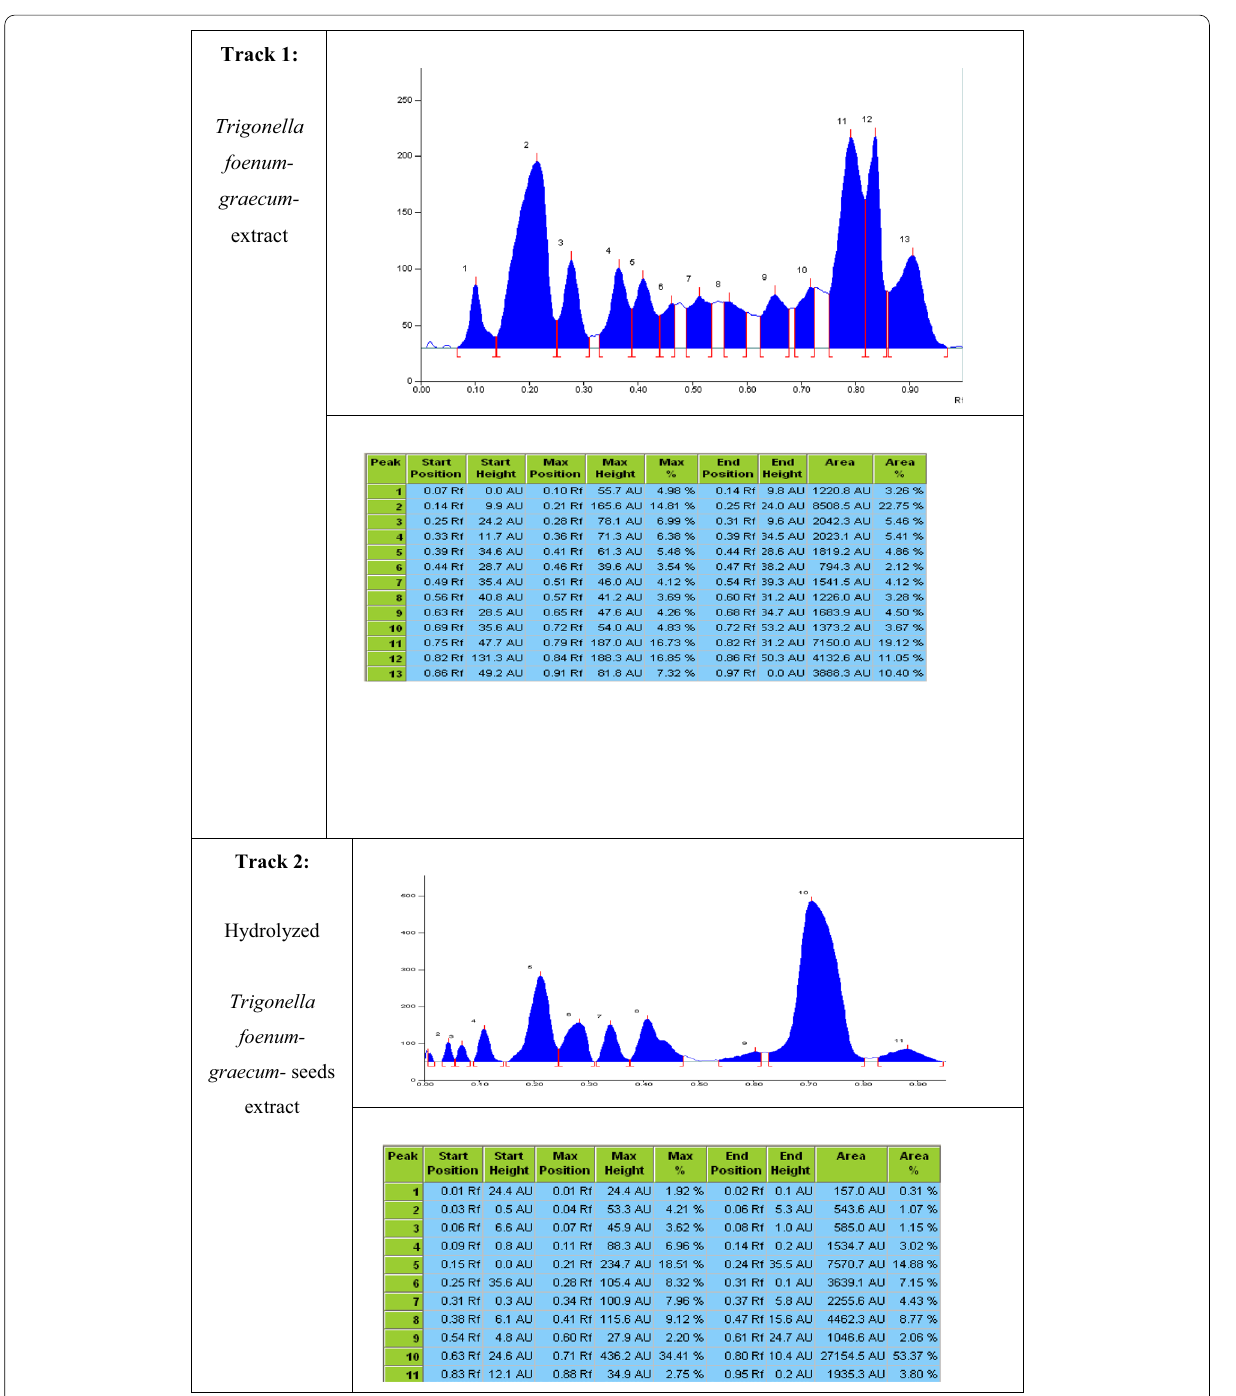
Fig. 6 HPTLC Fingerprint profiles of Trigonella foenum-graecum seeds extract, coded ayurvedic formulation extract, and Diosgenin reference standard at 540